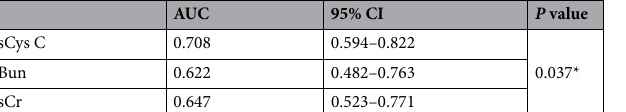
Table 2. Predictive performance of sCys C, Bun and sCr for severe COVID-19. Abbreviations: sCys C = serum cystatin C; Bun = blood urea nitrogen, sCr = serum creatinine, COVID-19 = coronavirus disease 2019,